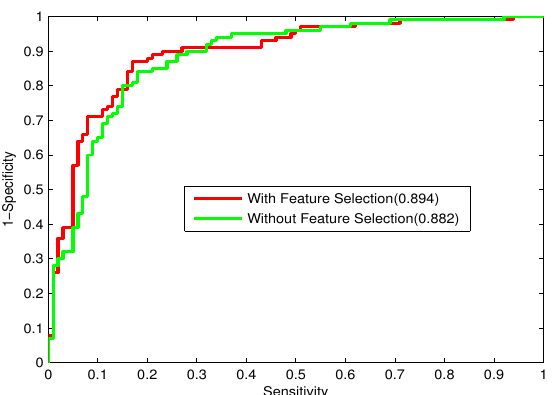
Figure 7. ROC curves of the stacking-based ensemble learning methods with and without feature selection.